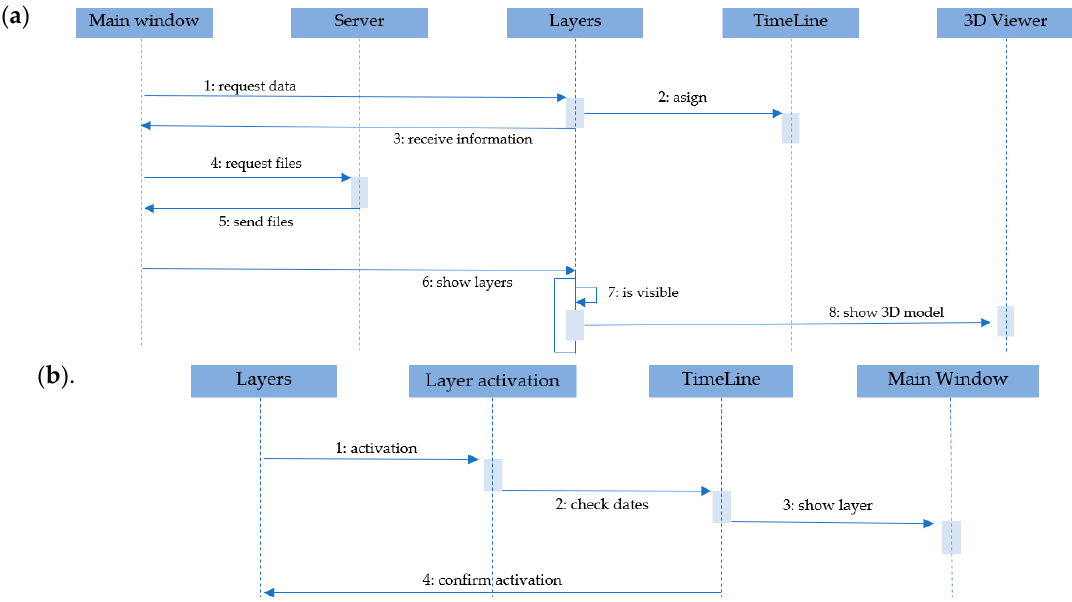
Figure 5. Diagram of the sequences followed by the four-dimensional (4D) viewer: ( a ) sequence to load the data into the three-dimensional (3D) viewer; and ( b ) sequence used for the layer activation.